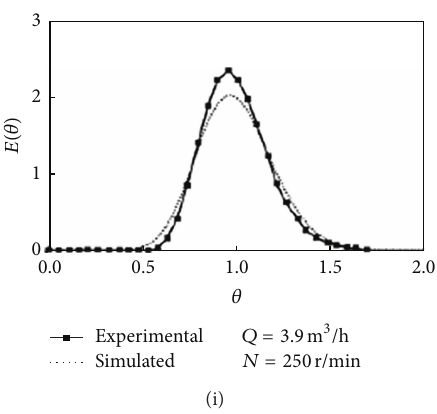
Figure 10: Example of reactor malfunction from RTD curves by Cao et al. 2009 [43].